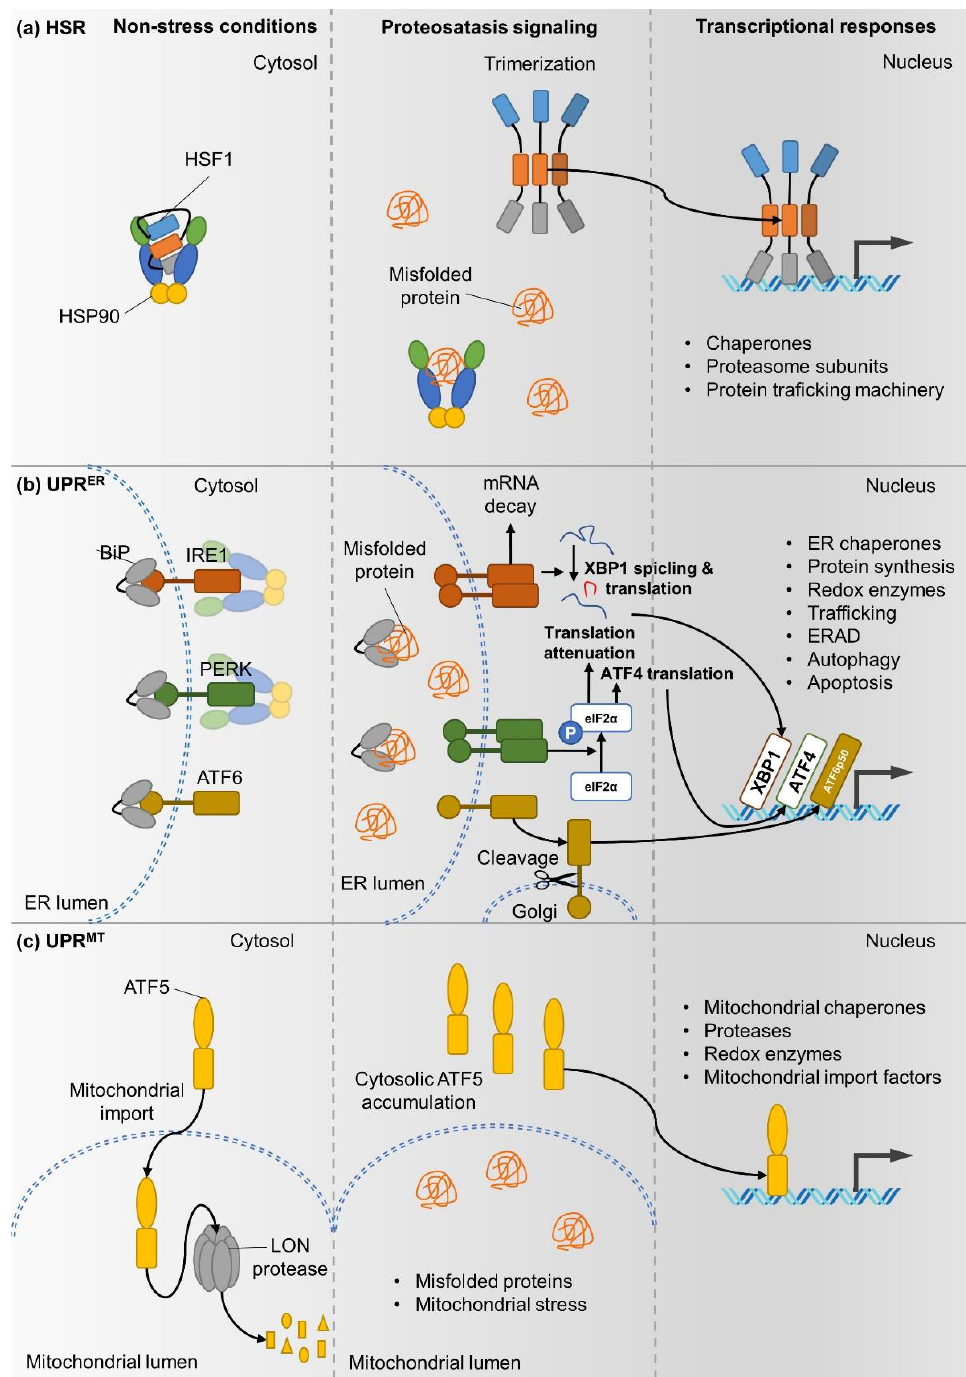
Figure 1. Compartment-specific proteostasis pathways. ( a ) The cytosolic heat shock response (HSR). ( b ) The unfolded protein response of the endoplasmic reticulum (UPR ER ). ( c ) The mitochondrial unfolded protein response (UPR MT ). A general theme is the direct detection of and feedback regulation by misfolded proteins.